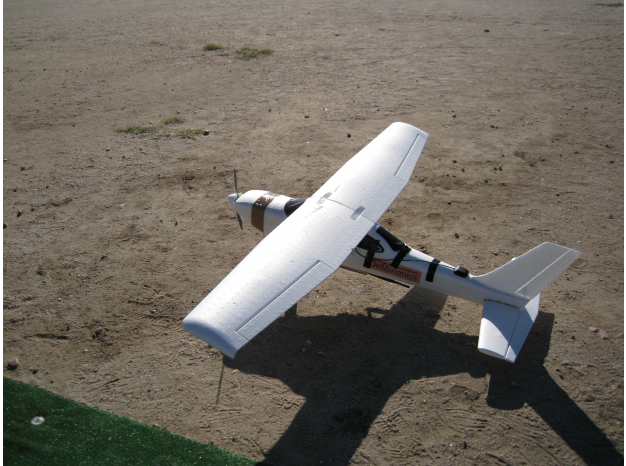
Figure 1. Mentor Multiplex aircraft modified by the authors to be a